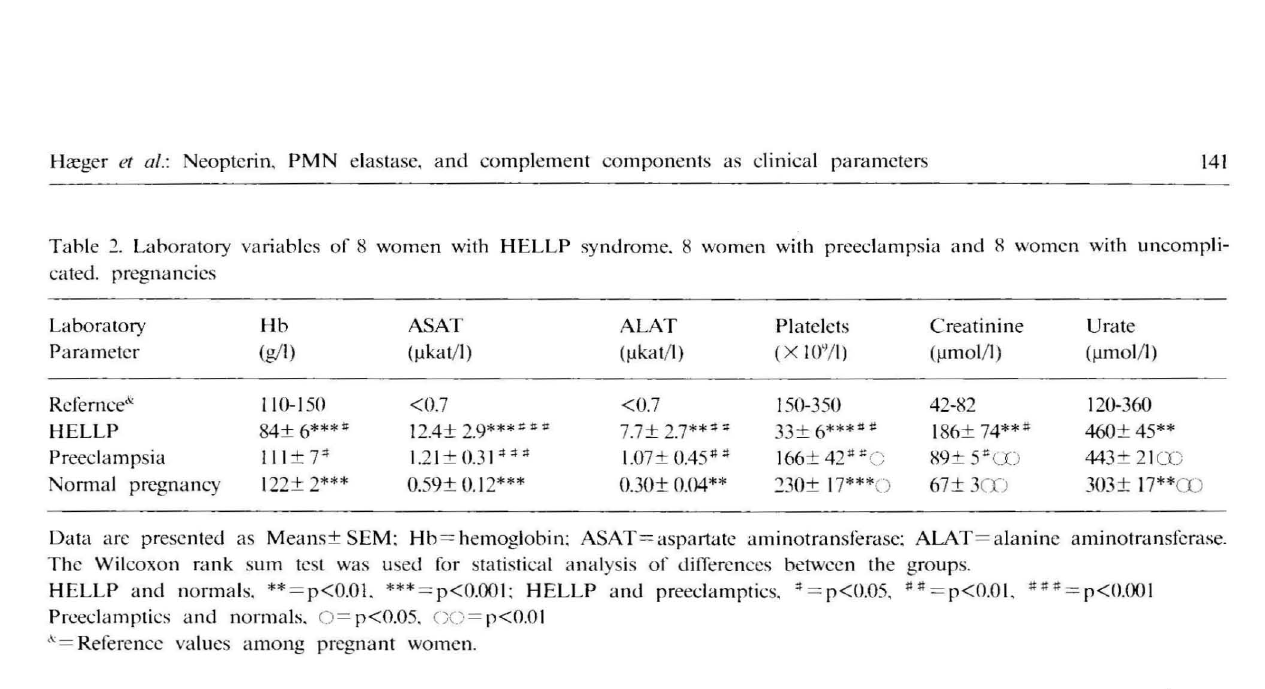
Table 3. Plasma concentrations of neopterin. polymorphonuclear e1stase and complement components in 8 womcn with HELLP syndrome. 8 women with preeclampsia and 8 women with uncomplicated